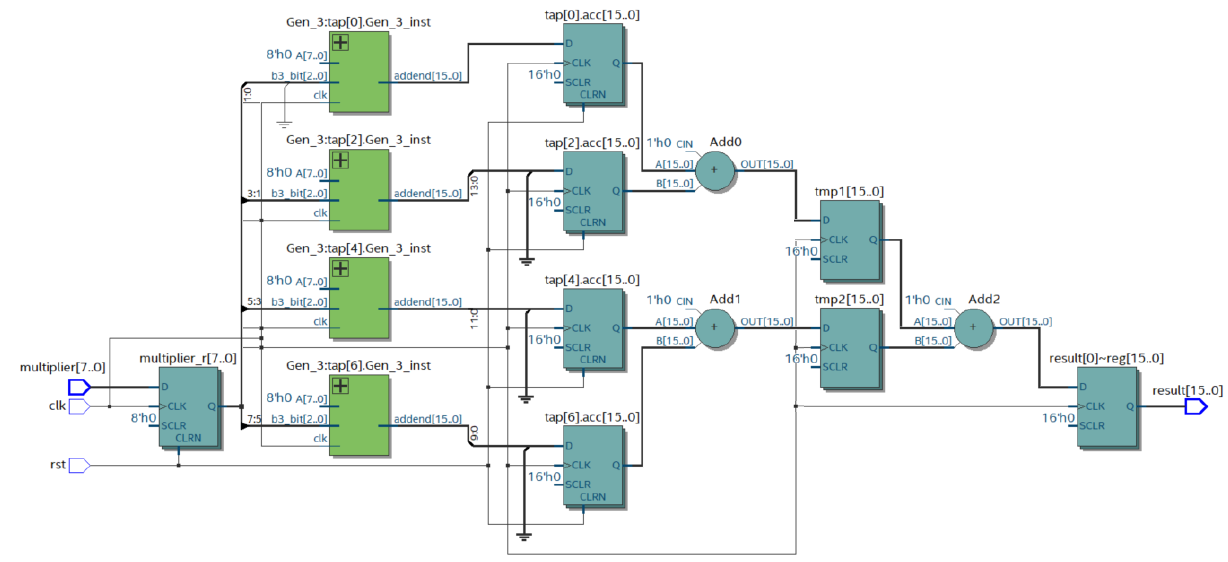
Figure 8. RTL of a pipeline multiplier implementing multiplication by a constant based on the modified Booth’s algorithm for n = 8.